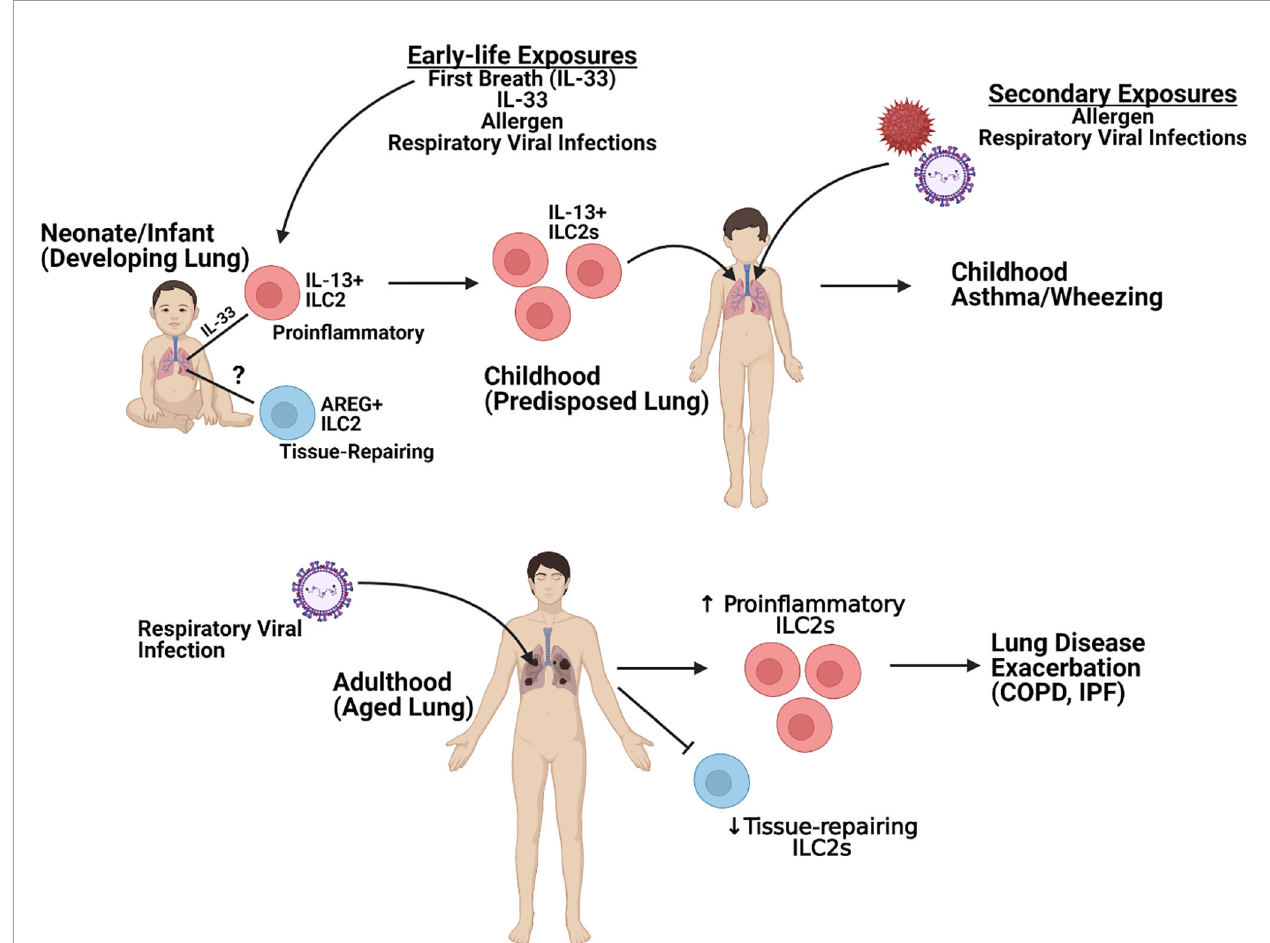
FIGURE 2 | Overview of ILC2-speci fi c Lung Pathogenesis. Figure created using